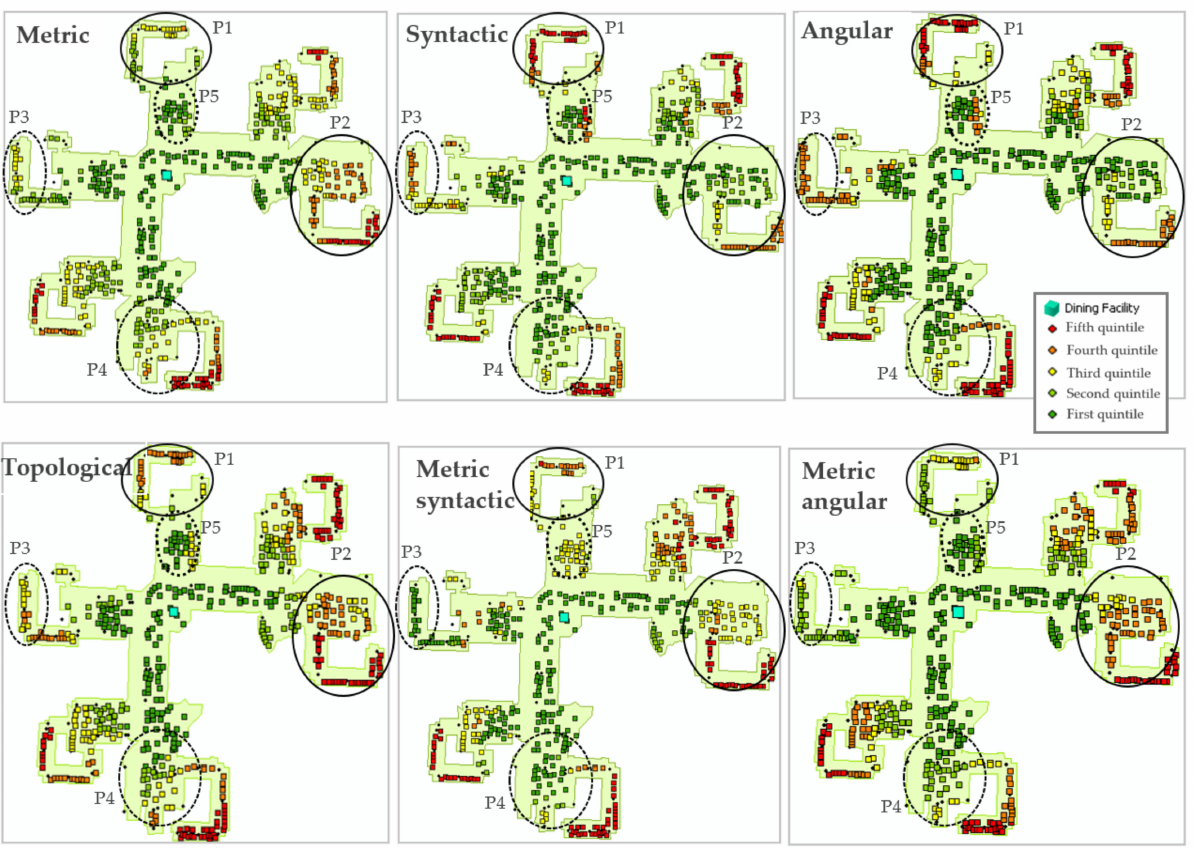
Figure 19. Floor 1 accessibility to dining facility 3 (P = point of analysis, highlighted for comparison among different approaches) based on different approaches: classification in